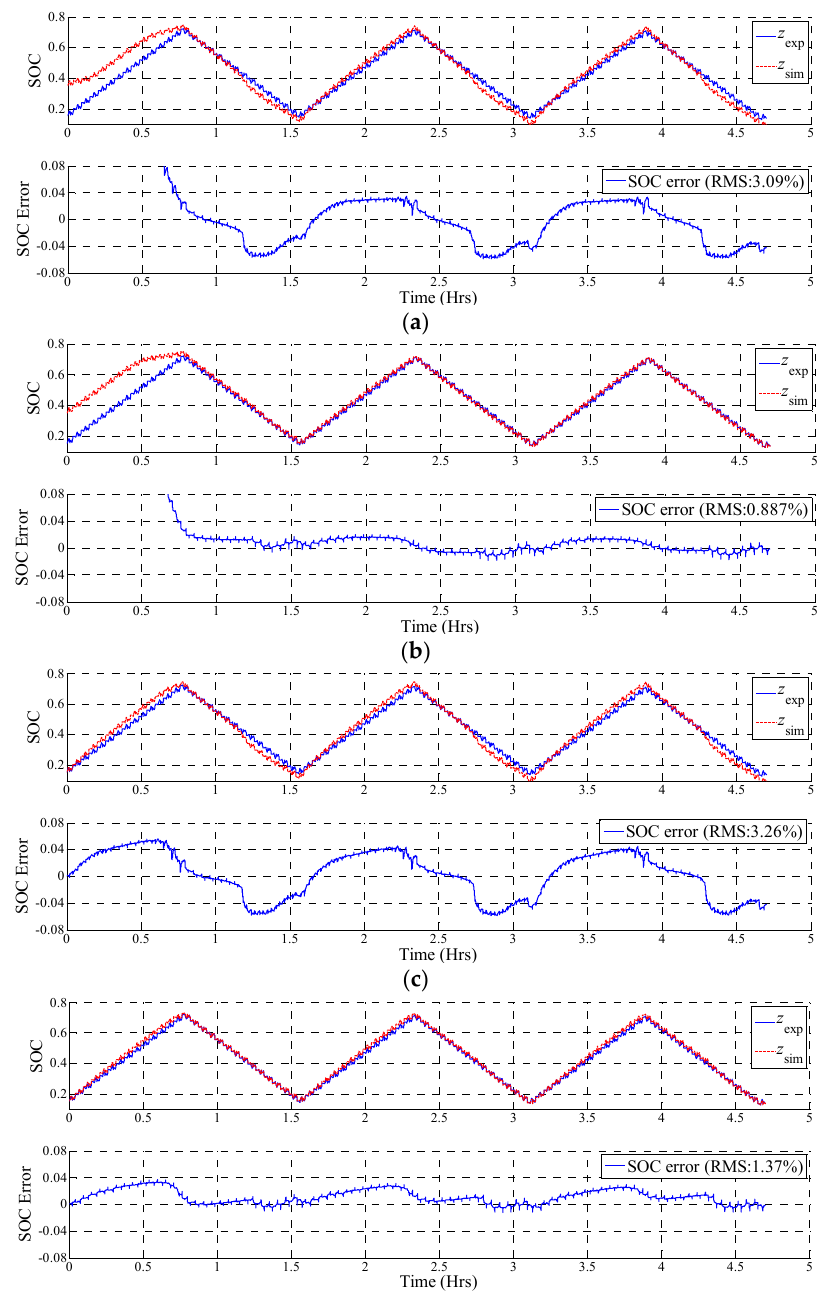
Figure 9. SOC estimation using extended Kalman Filters (EKF) with ( a ) current independent parameters given 20% initial SOC error; ( b ) current dependent parameters given 20% initial SOC error; ( c ) current independent parameters given 0.5 A biased current measurement; and ( d ) current dependent parameters given 0.5 A biased current measurement.